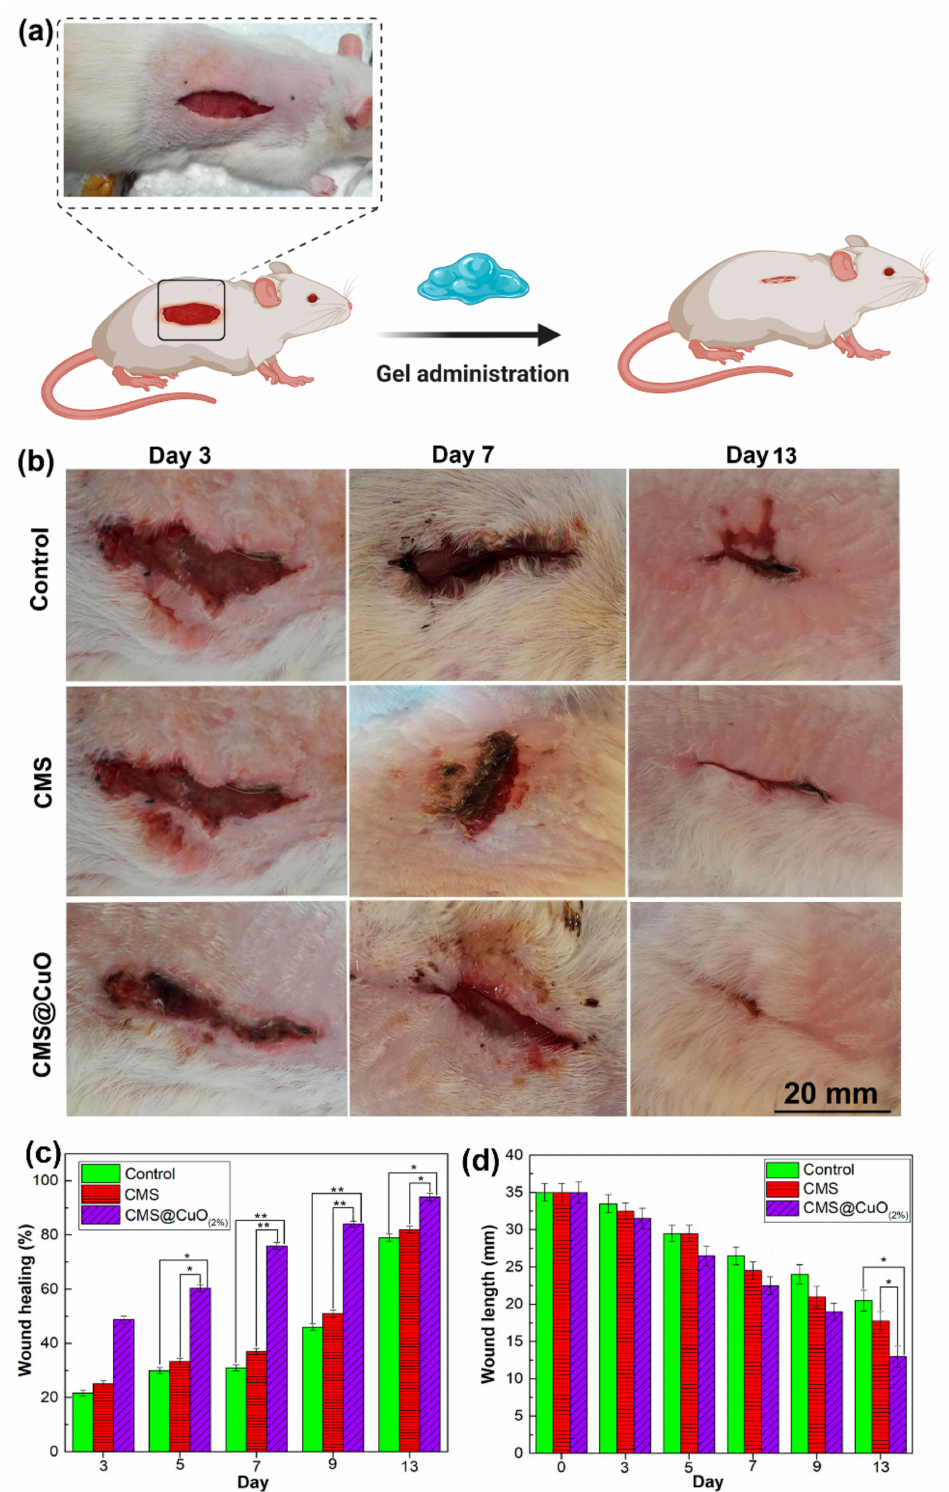
Figure 7. Macroscopic photographs of the wounds treated with the control, CMS, and the CMS@2%CuO nanocomposite hydrogel specimens at different time periods ( a , b ) and histograms of the percentage of wound healing ( c ) and wound length ( d ). For each chart, columns labeled with an asterisk (* , **) are significantly different from the control ( p < 0.05 and p <